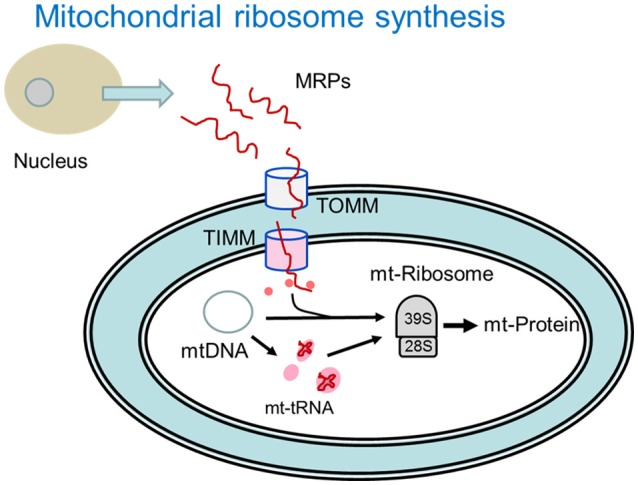
Depiction of mitochondrial ribosomal protein (MRP) import and synthesis of mitochondrial (mt) proteins encoded by mitochondrial DNA (mtDNA) enriched in the high feed efficiency pedigree male broiler phenotype. MRPs are synthesized in the nucleus and imported into the mitochondria through outer mitochondrial membrane transport (TOMM) proteins and inner mitochondrial mitochondrial membrane proteins (TIMM). Once inside the mitochondria, mt transfer RNAs (mt-tRNA) encoded by mtDNA facilitate protein translation that takes place on the mitochondrial 39S and 28S ribosomal subunits. Pink or red color denotes processes that were enriched in the high feed efficiency pedigree broiler male as indicated in Table 3 (See text for more details).